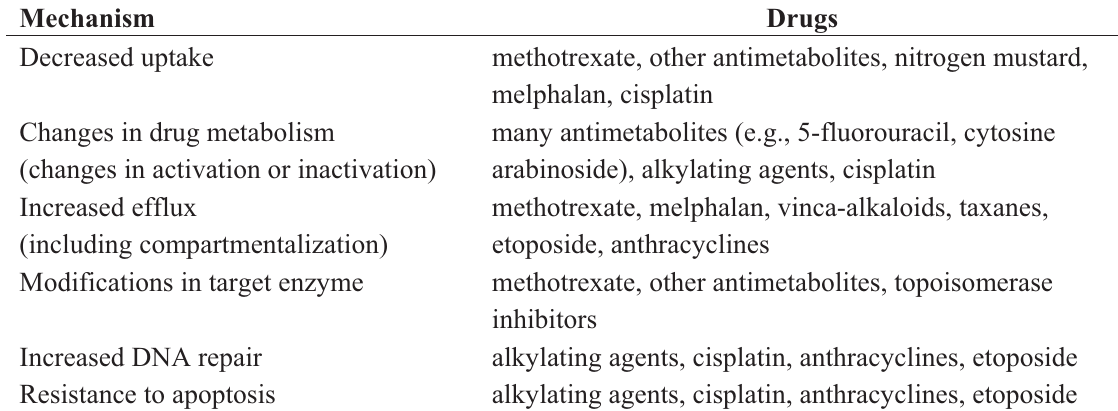
Table 1. Major drug resistance mechanisms identified for the classical cytotoxic agent drug